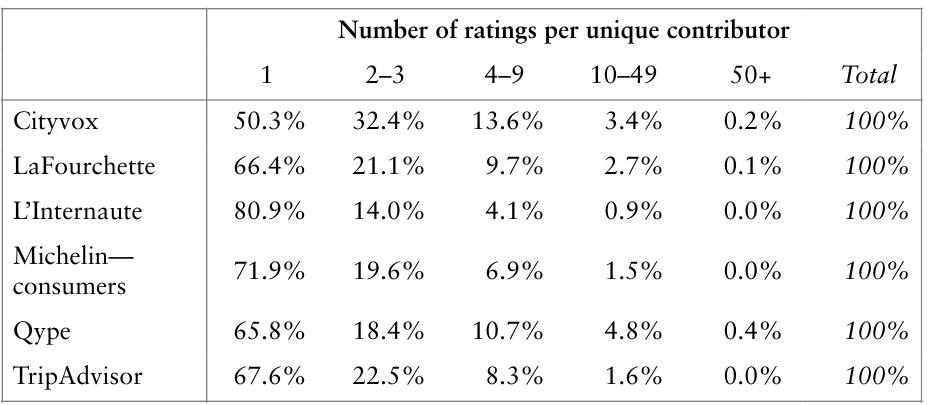
Table 7. Distribution of the number of ratings per contributor.